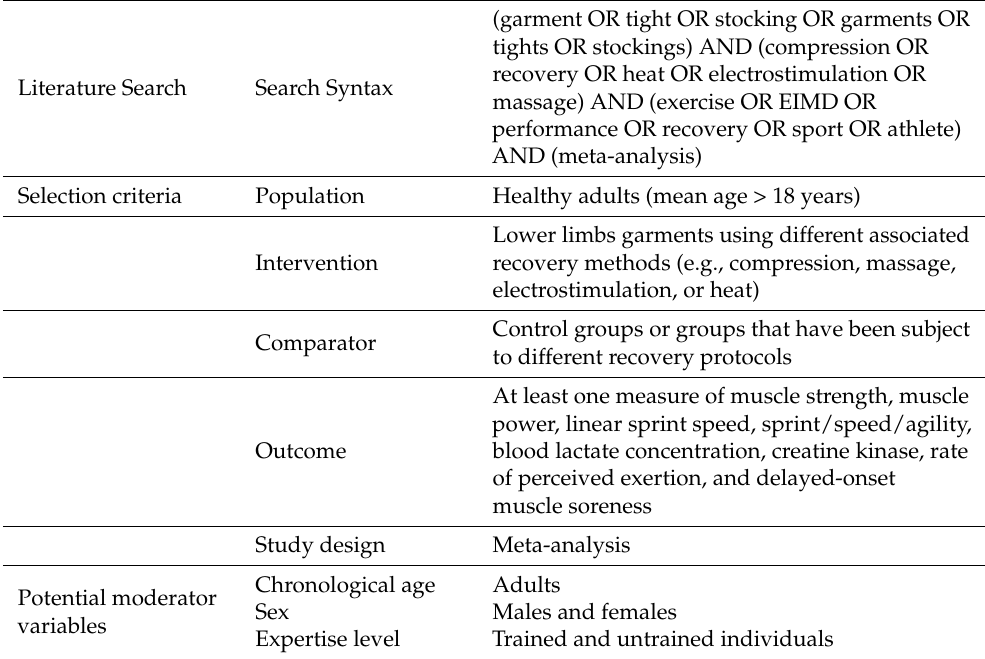
Table 1. Information on the literature search, selection criteria, and considered moderator variables.